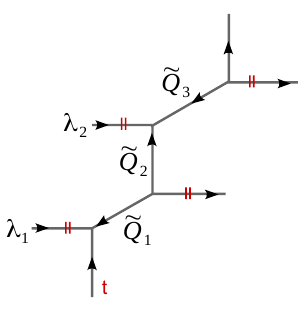
Figure 9 . The strip geometry, with the assignment of K(cid:127)ahler parameters, the choice of preferred direction and a pair of Young tableaux decorations on external